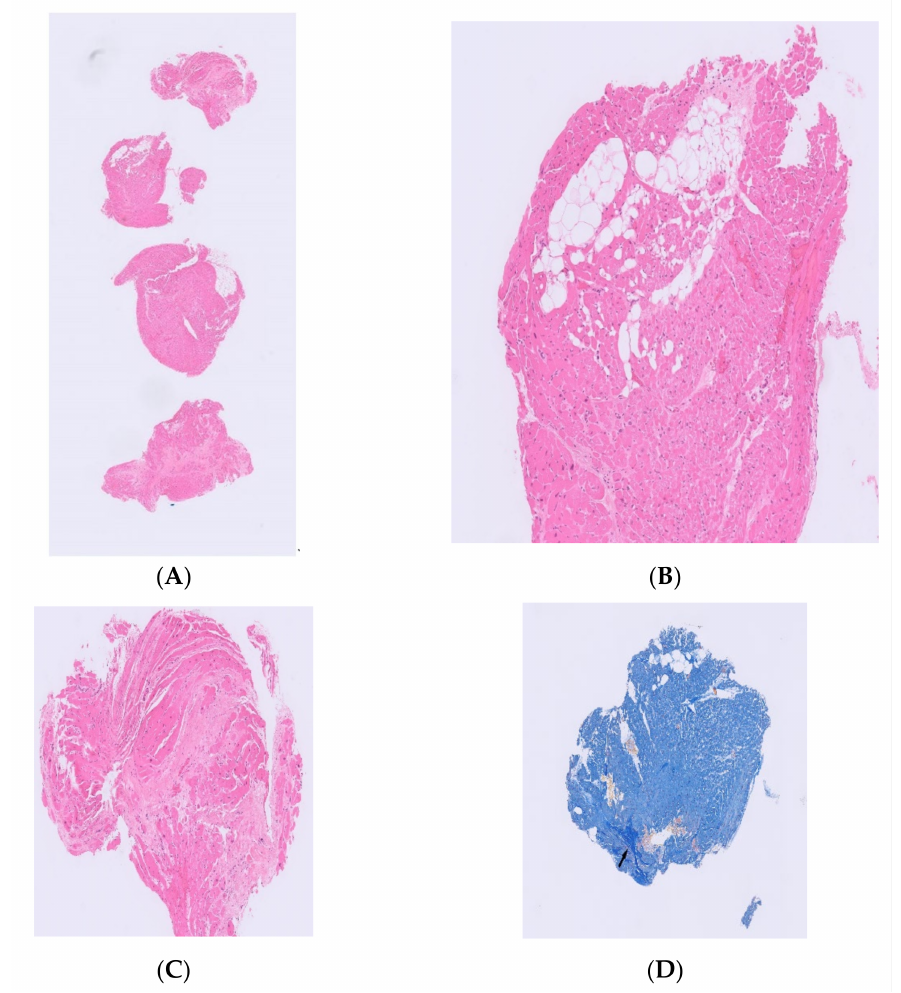
Figure 2. ( A ) Ultra low power image (H&E). In this image, four fragments of endomyocardium are included for assessment. Note the presence of adipose tissue in some of the fragments. Other fragments appear to show some fibrous replacement of the cardiac myocytes. ( B ) Medium power ( × 10 H&E). This medium power image shows myocardium with areas of interstitial fibrosis. There is mature adipose tissue and a suggestion of associated fibrous tissue at the top of the section, but this was not demonstrated on tinctorial staining. There is myocyte nuclear hypertrophy and focal areas of myocytolysis were seen. No increase in the cellularity of the interstitium was seen. No granulomas were identified. ( C ) This medium power ( × 10, H&E) image of another fragment from the biopsy set shows myocardium with areas of replacement fibrosis. Tinctorial staining for excess iron and amyloid deposition were negative (not shown). ( D ) In this medium power image ( × 10 MSB), the arrow demonstrates an area of fibrosis. No definite established fibrosis can be seen in association with the adipose tissue in this